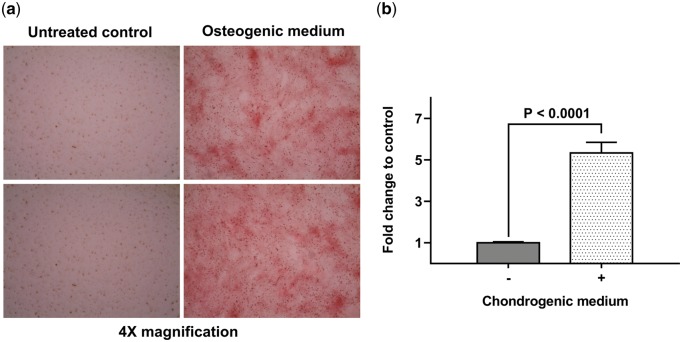
Differentiation of MSCs. (a) ARS staining of MSCs grown in the osteogenic medium for 14 days (right) and untreated cells (left). All pictures were taken at 4× magnification. (b) Results of RT-PCR: fold change of ACAN expression in MSCs grown in the chondrogenic medium for 21 days compared with untreated cells